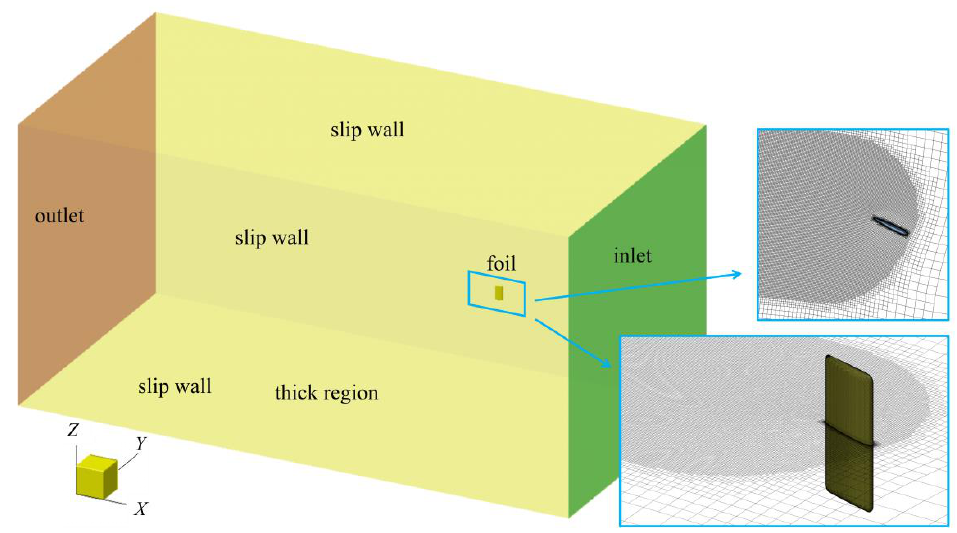
Figure 3. Schematic diagram of the computational domain and gradual mesh refinement.